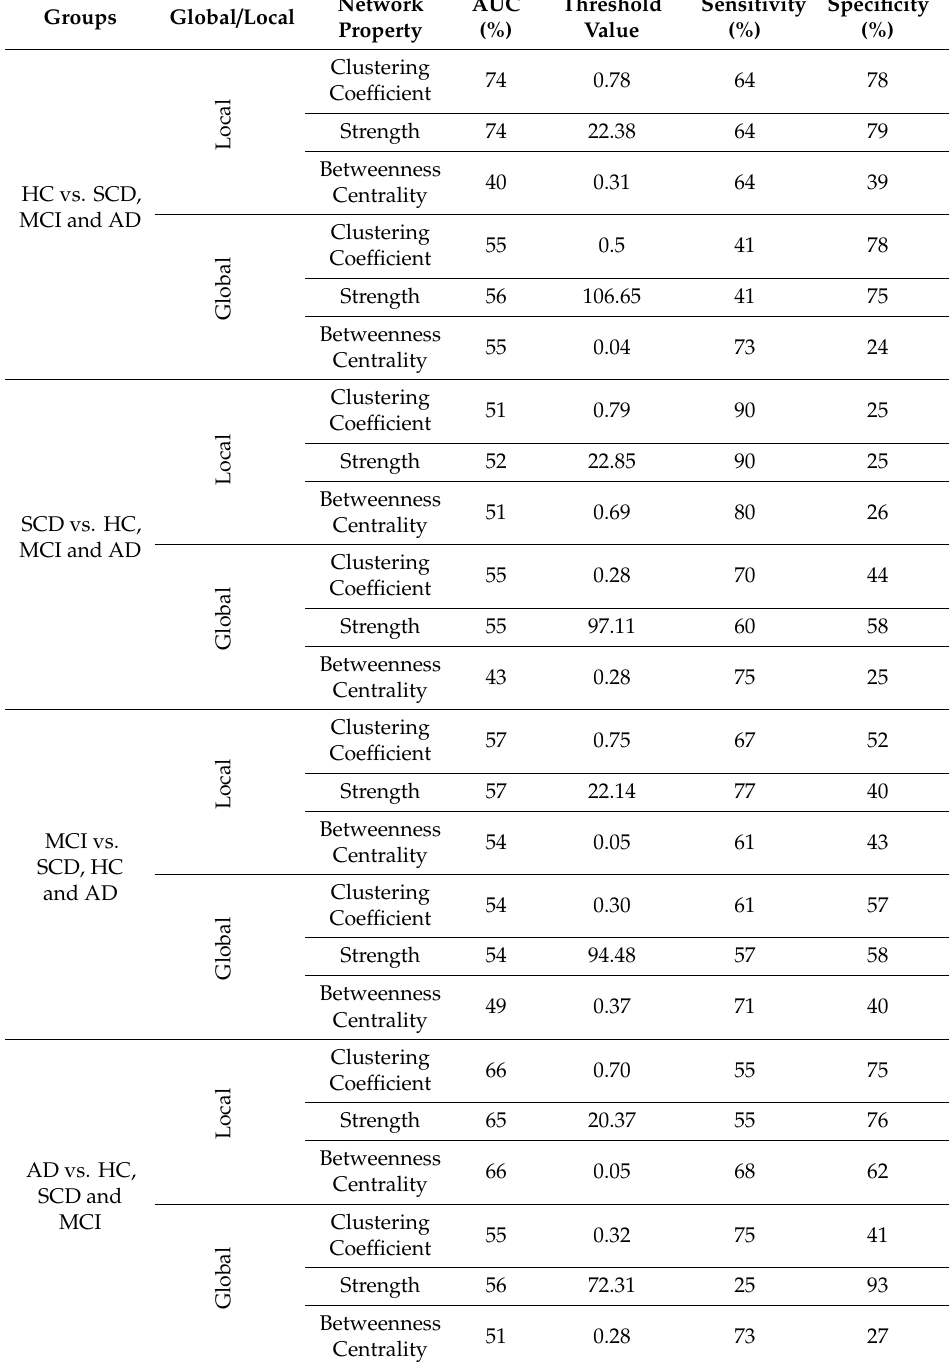
Table 4. Sensitivity and specificity of clustering coe ffi cient, strength and betweenness centrality at global and local levels for each group compared with one of the other three